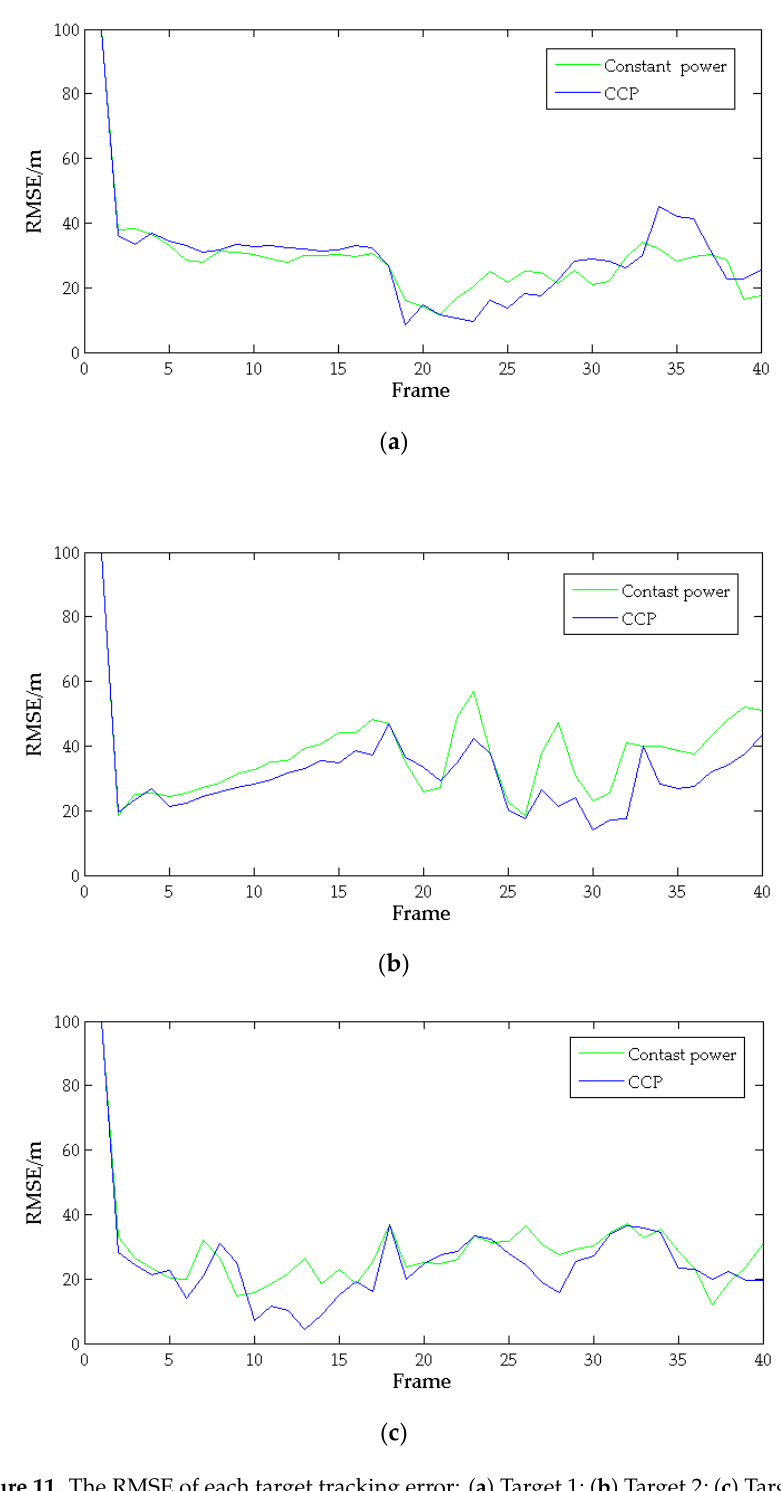
Figure 11. The RMSE of each target tracking error: ( a ) Target 1; ( b ) Target 2; ( c ) Target 3.